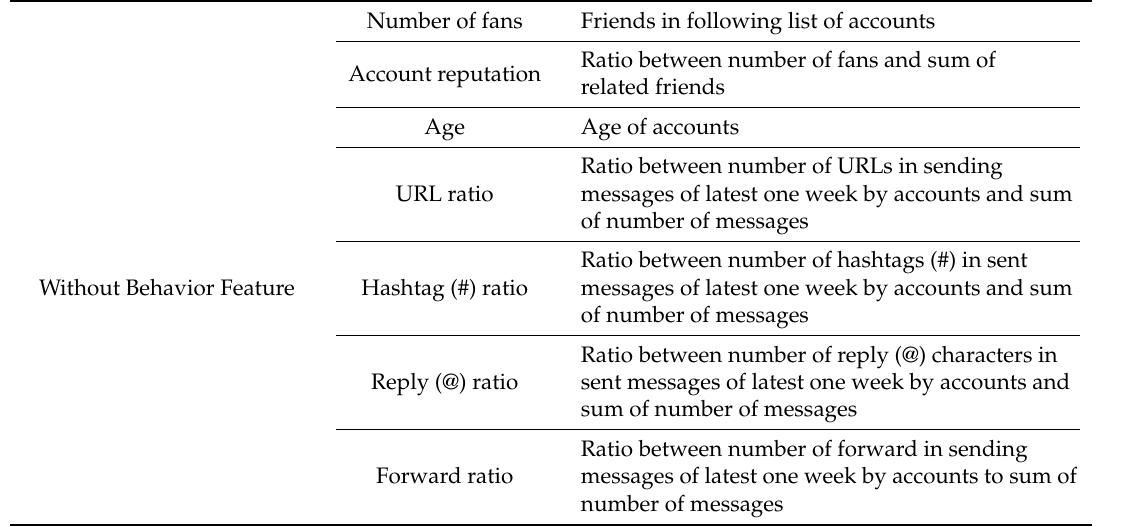
Table 1. Feature sets.